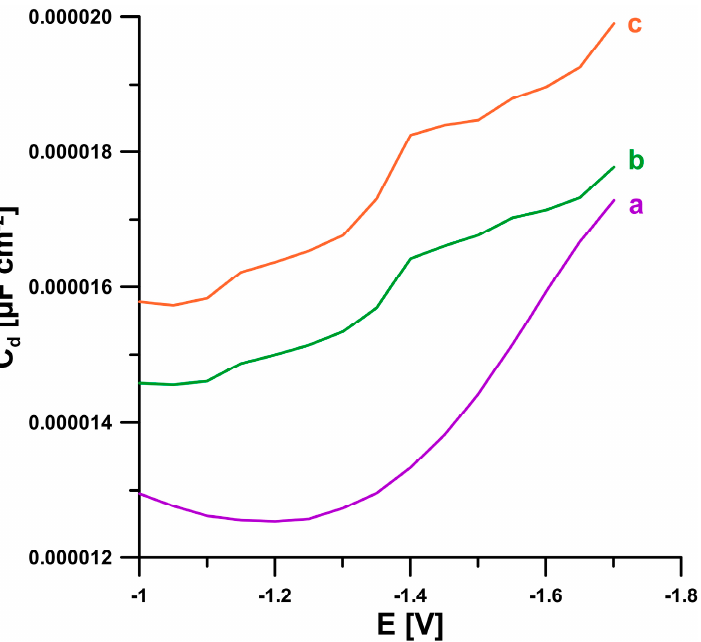
Figure 5. The differential capacity-potential curves of the double layer interface pSPCE/PbNPs/NaAc—HAc buffer (pH 4.5) in the presence of 0 (a), 2 (b), and 5 (c) µM BLM.